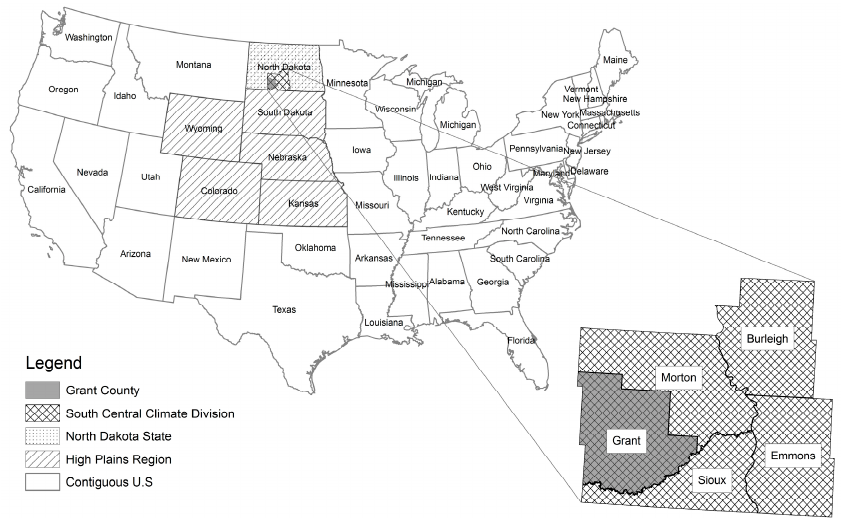
Figure 1. Spatial scales considered in this study.